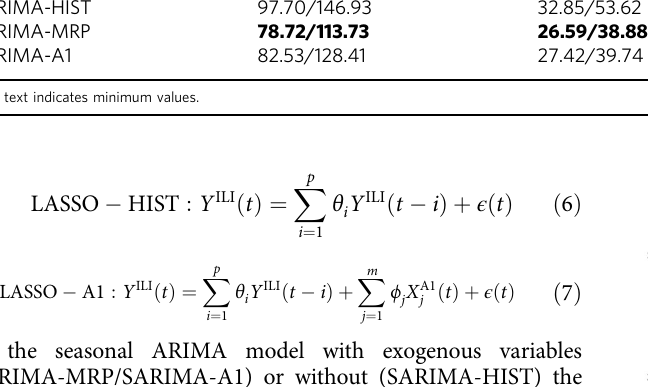
Table 3 State-level tracking model RMSE ( h = 1 week/ h = 2 weeks). Signal NM